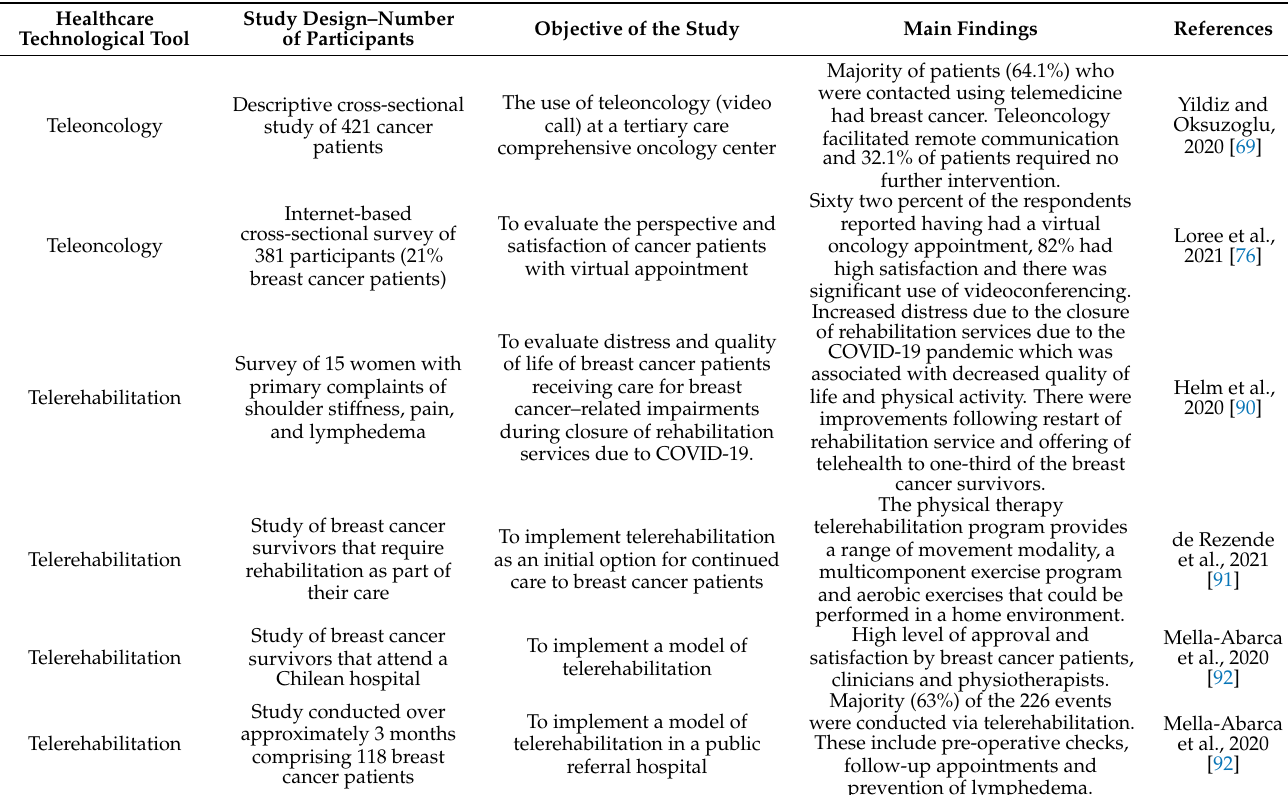
Table 2. The utilization and benefits of teleoncology and telerehabilitation to breast cancer patients during the COVID-19